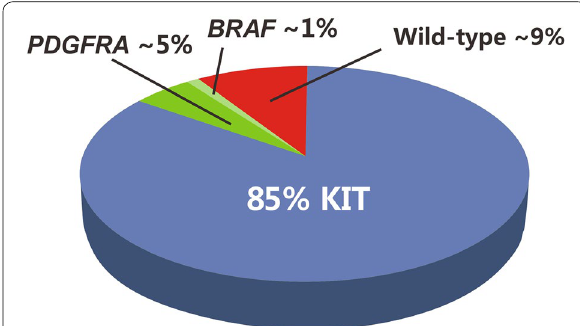
Fig. 1 Molecular subsets of gastrointestinal stromal tumors (GISTs). Gene that encodes a receptor tyrosine protein associated with a mast cell growth factor receptor ( KIT ); platelet-derived growth factor receptor A ( PDGFRA ); gene that encodes an enzyme belonging to the RAF family of serine-threonine protein kinases participating in the RAS-RAF-ERK pathway ( BRAF ); wild-type (WT) normal gene sequence that does not contain any somatic